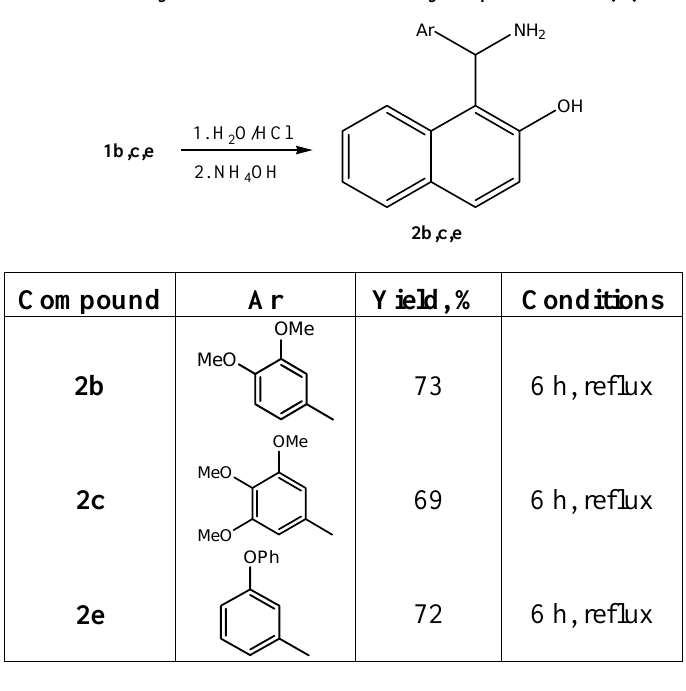
Table 2. Synthesis of aminobenzylnaphthols 2b,c,e .